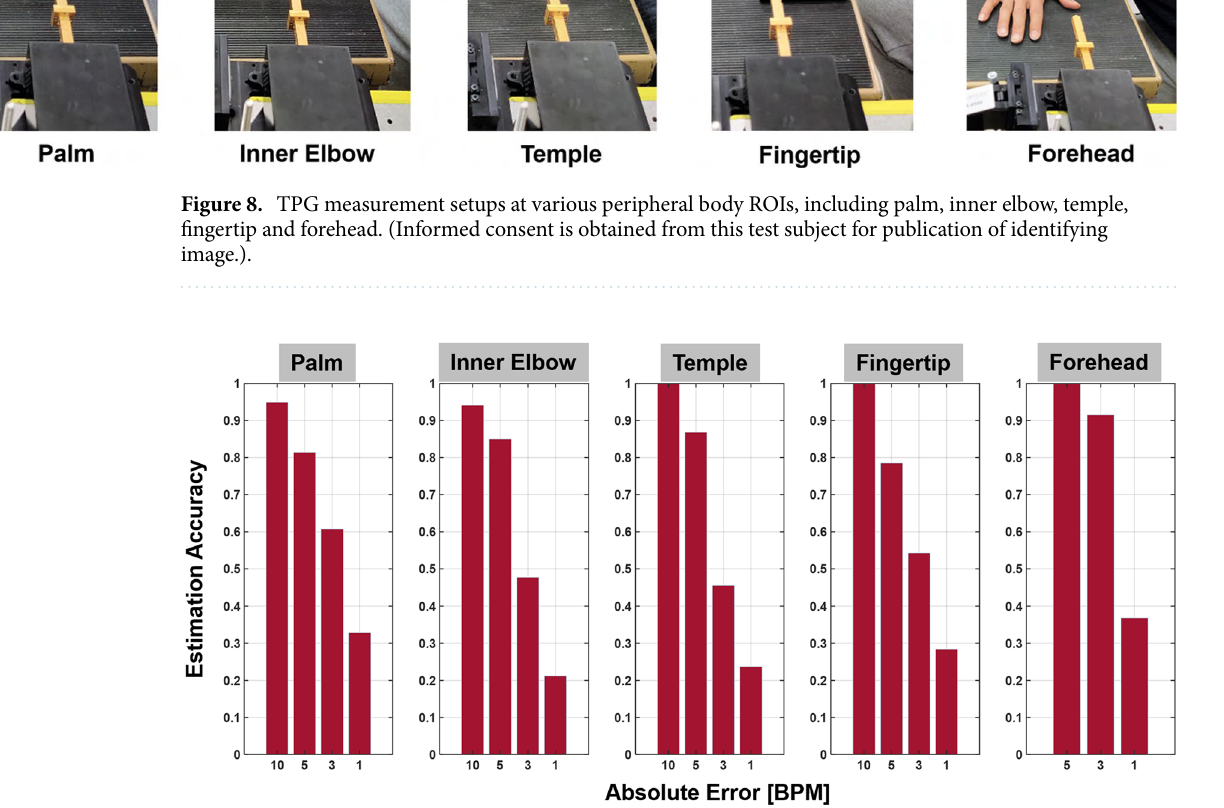
Figure 9. HR estimation error histograms at various peripheral body ROIs in Fig. 8. Each histogram shows the percentage of HR estimates that its estimation error is within ( ) 10, 5, 3 and 1 BPM respectively. Palm: 94.9 % ≤ 10, 81.4 % 5, 60.8 % 3, 32.8 % 1; inner elbow: 94.1 % , 85.0 % , 47.7 % , 21.2 % ; temple: 100 % , 86.8 % , 45.6 % , ≤ ≤ ≤ ≤ 23.7 % ; fingertip: 100 % , 78.5 % , 54.3 % , 28.4 % ; forehead: 100 % , 91.5 % , 36.8 % .